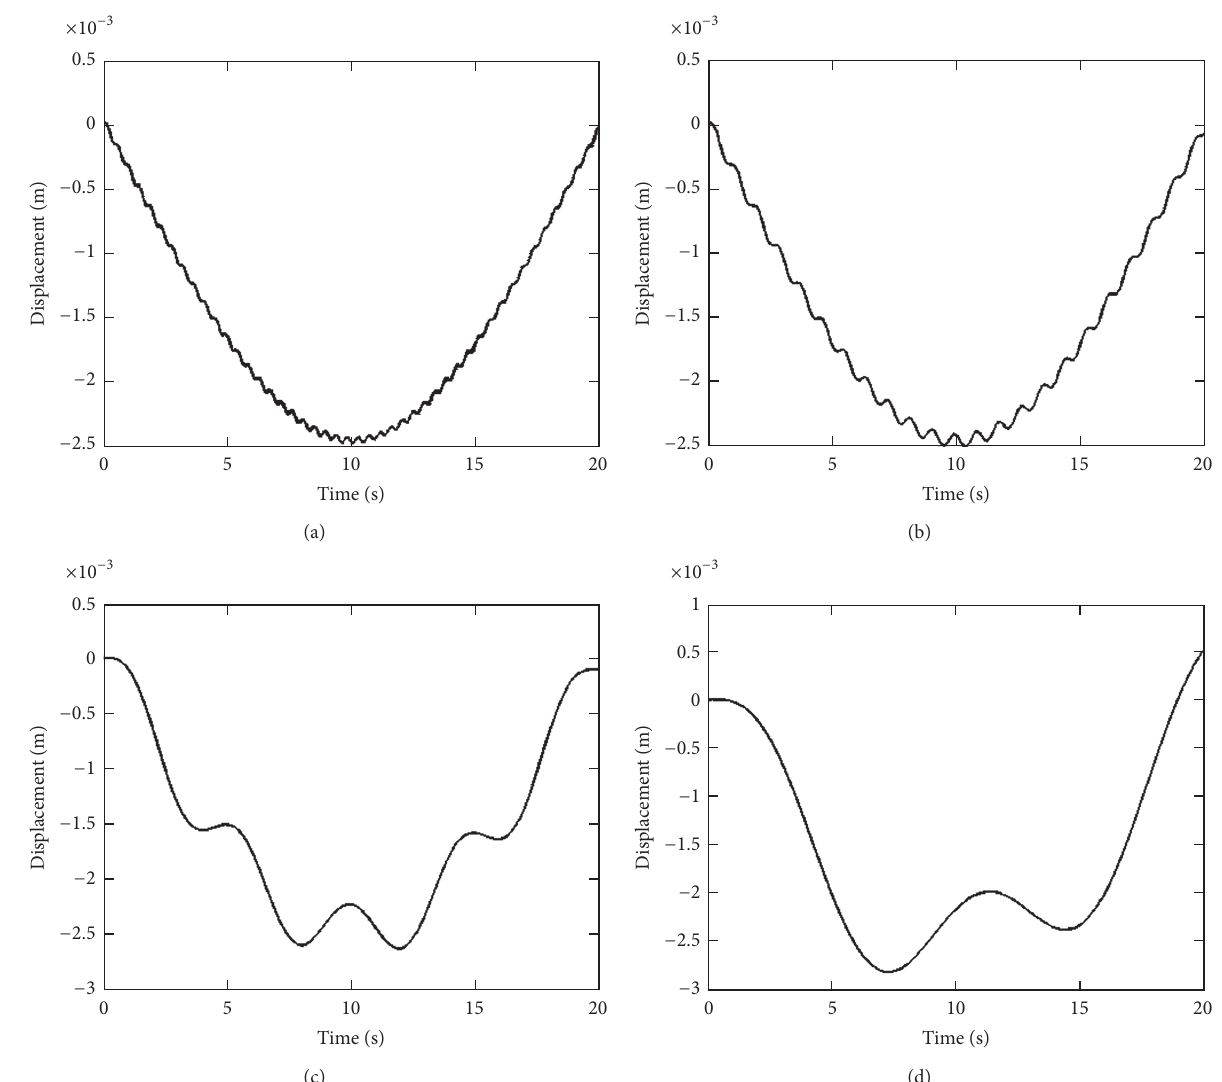
Figure 24: Displacement responses of different mass velocity scenarios with 𝑚 𝑚 = 200 Kg, 𝐿 𝑑 = 0.4 , and 𝐿 𝑠 = 0.5 : (a) V = 0.5 m/s, (b) V = 1 m/s, (c) V = 5 m/s, and (d) V = 10